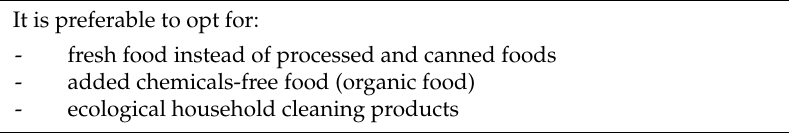
Table 1. Recommendations towards protection of humans from EDCs